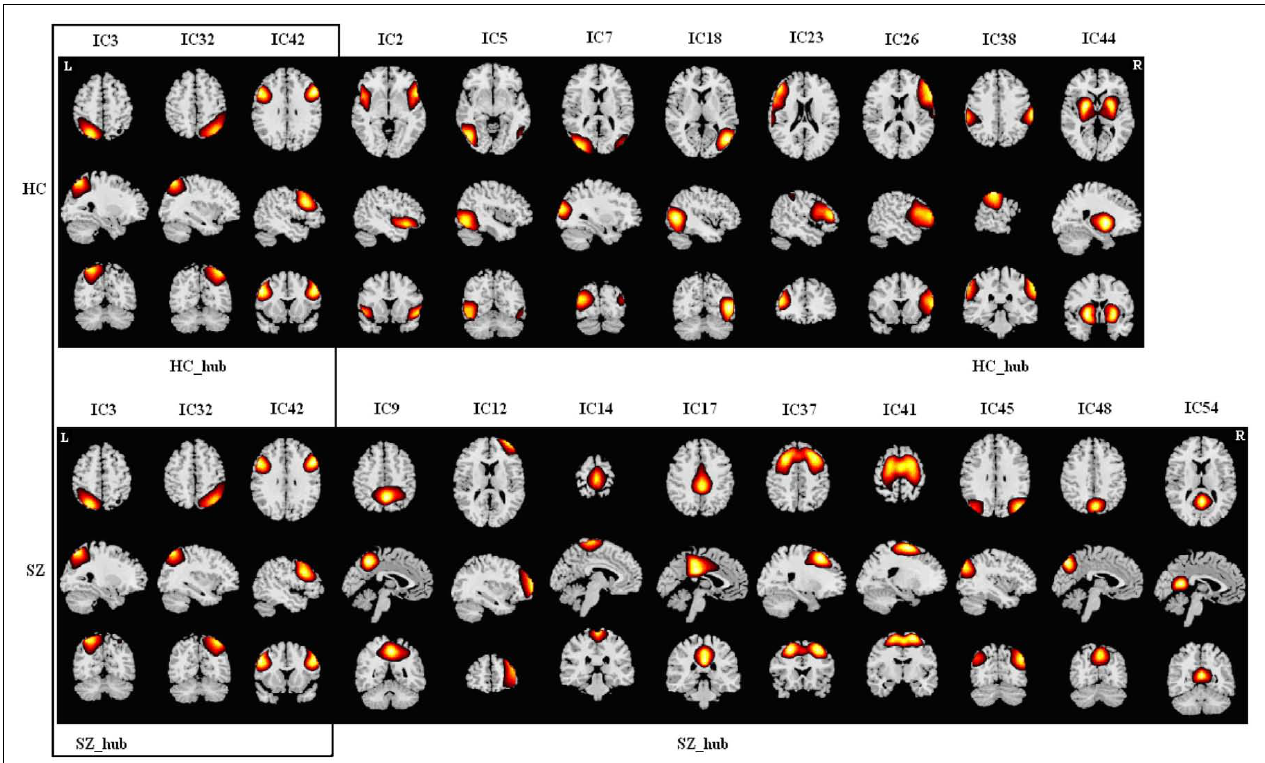
putamen component, and one temporal-frontal component. SZs have another nine components including three frontal components, three precuneus component, one angular component, one cingulum component, and one central component. As most of the components of this module in HCs are from attention network, we designated this module as “Attention Module” (A Module).There are two different hubs in this module for the two